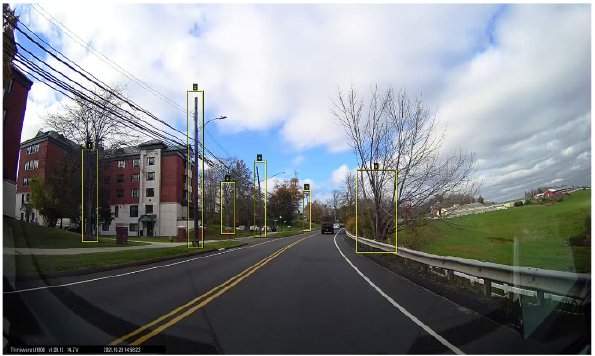
Figure 3: Tree trunks and Poles annotated from dashcam Image frames